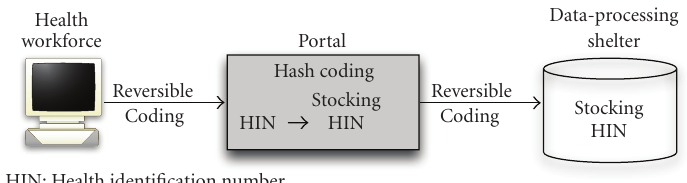
Figure 1: Schema of the proposed